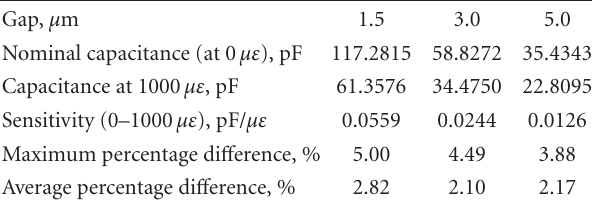
Figure 4: Boundary condition applied in finite element analysis. Table 4: Simulation results for di ff erent electrode gaps.